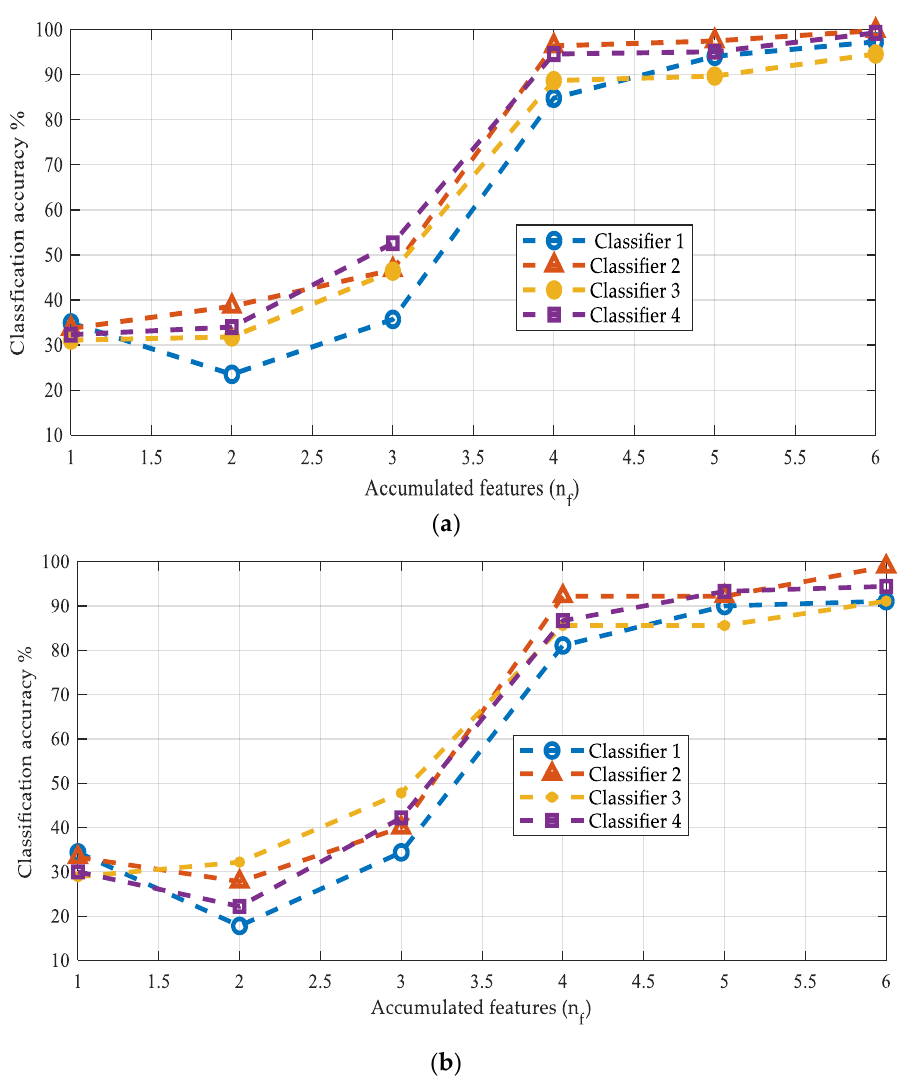
Figure 10. Classification accuracy for ANFIS classifier. ( a ) training data set; ( b ) testing data set.